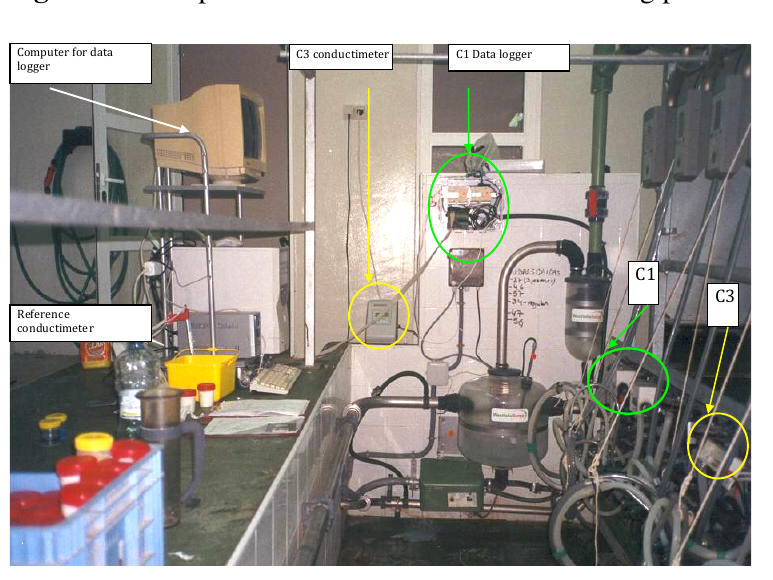
Figure 10. Setup of the conductimeters in the milking parlour.